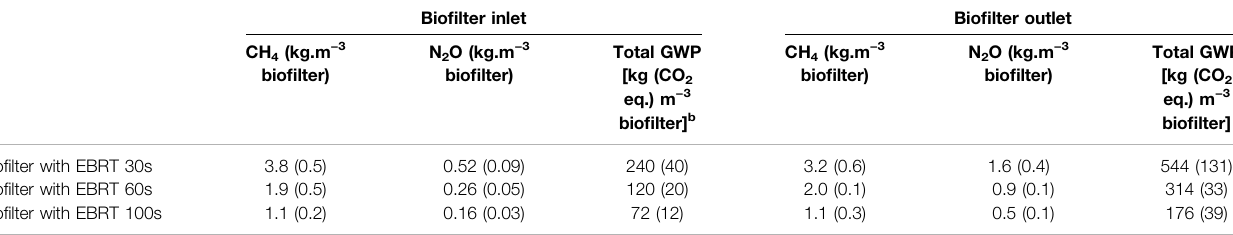
TABLE3| Cumulativenitrousoxide(N 2 O)andmethane(CH 4 )emissionsfrombio fi ltersusedforcompostingexhaustammonia(NH 3 )removal(valuesaremeans±SE, n =3) a